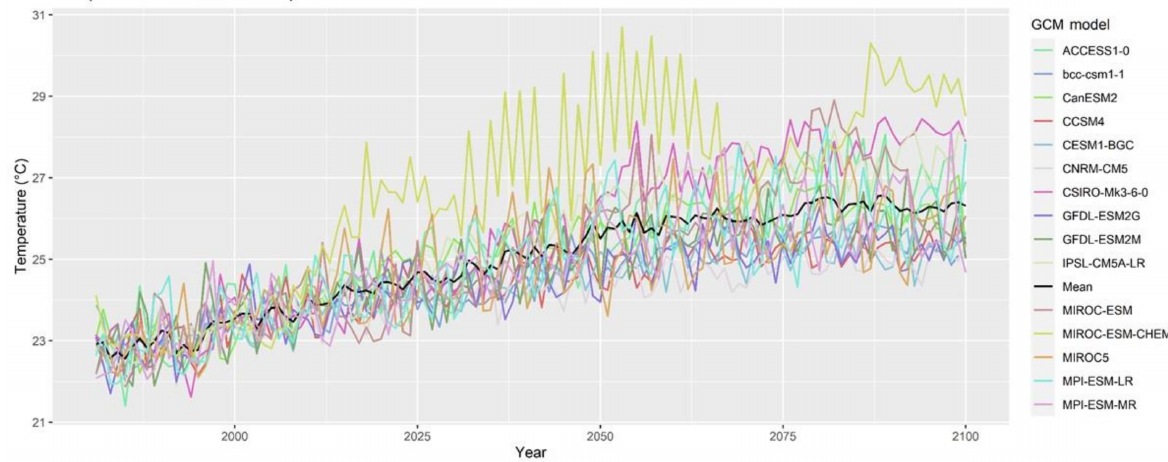
Figure 22. Maximum annual average temperature simulated by climate models, corrected and scaled for the Devil’s Creek, 1981–2100 term, RCP4.5 emission scenario. The black line represents the averaged ensemble of 15 GCMs.